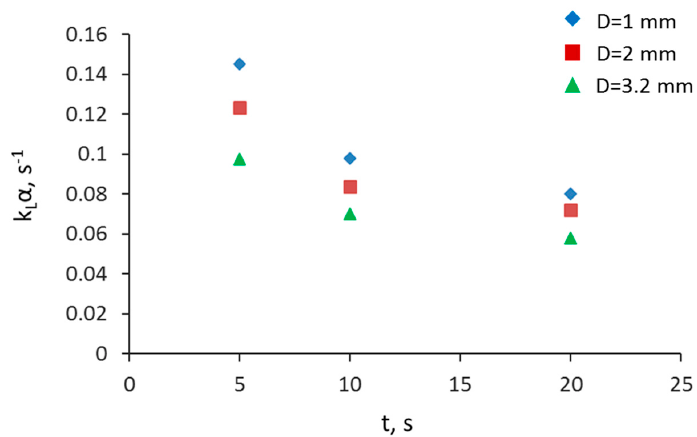
Figure 12. Effect of residence time on the overall mass transfer coefficient at different channel sizes and at constant mixture velocity (u mix = 0.017 m/s).